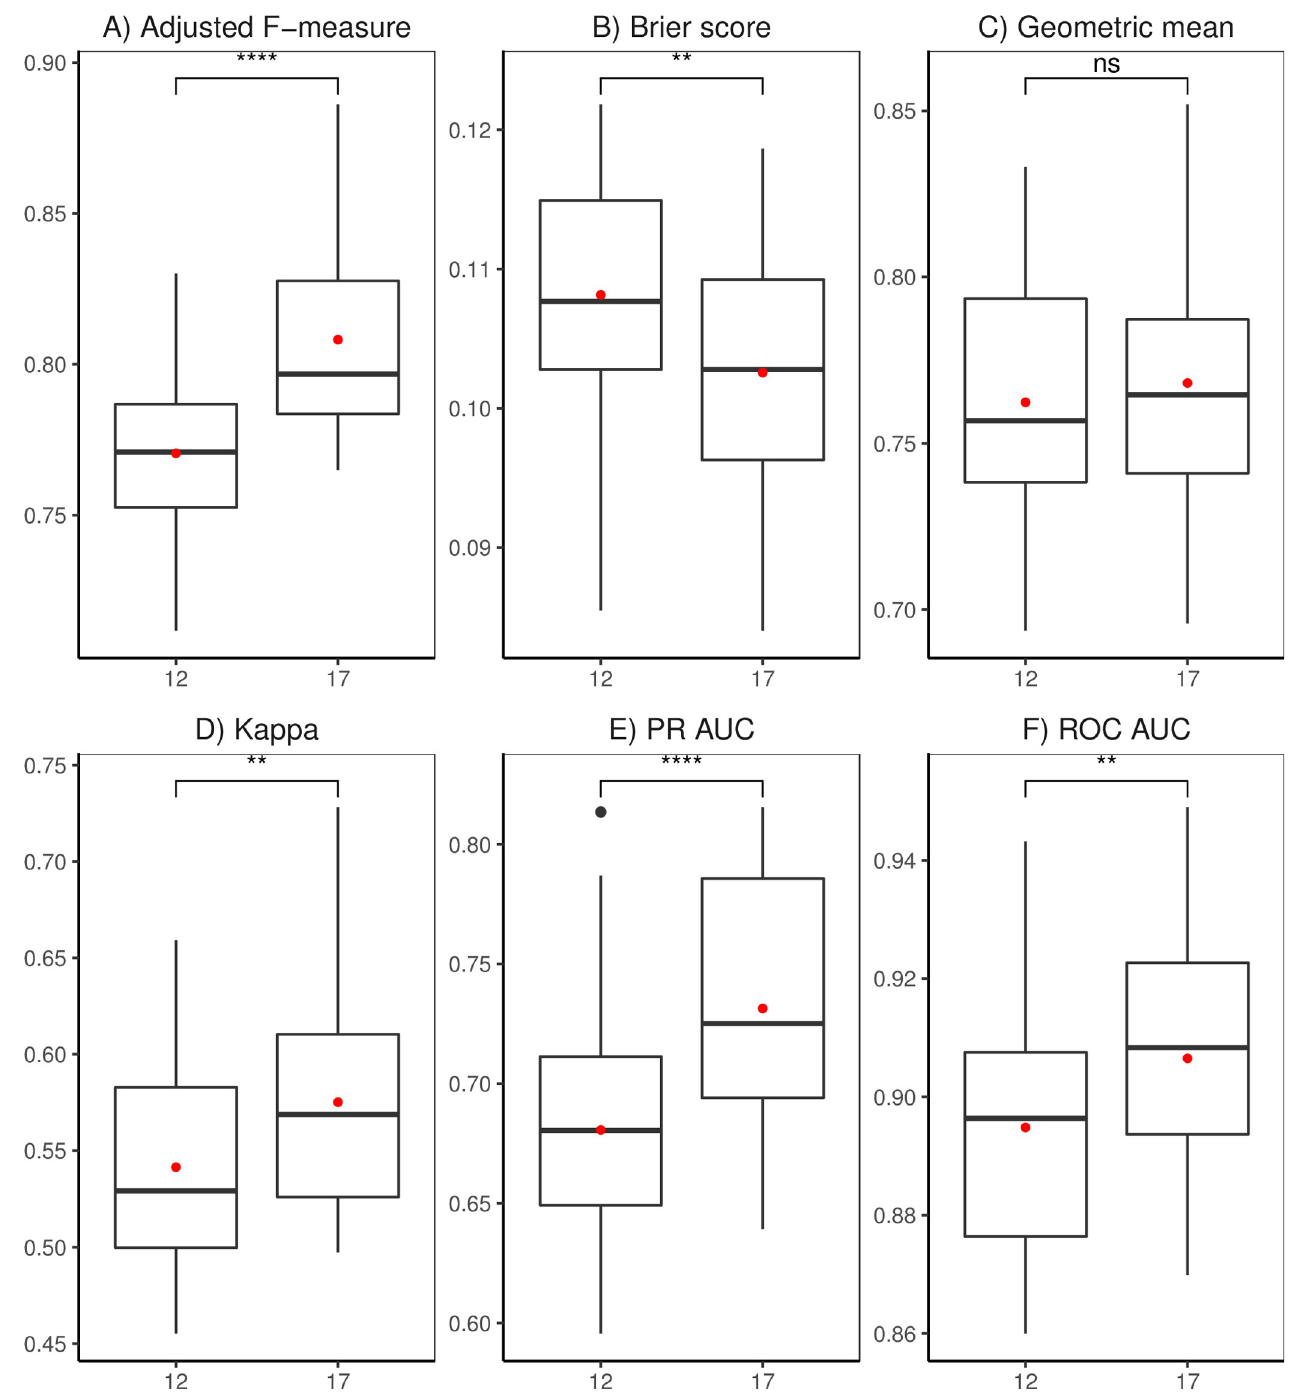
Fig 6. Performance metrics (A: Adjusted F-measure, B: Brier score, C: Geometric mean, D: Cohen’s Kappa, E: PR AUC, F: ROC AUC) for the ensemble models. The black line and red dot inside the box are the median and mean, respectively. Wilcoxon rank test significance values: Not significant (ns) p > 0.05; � p < 0.05; �� p < 0.01; ��� p < 0.001; ���� p < 0.000.